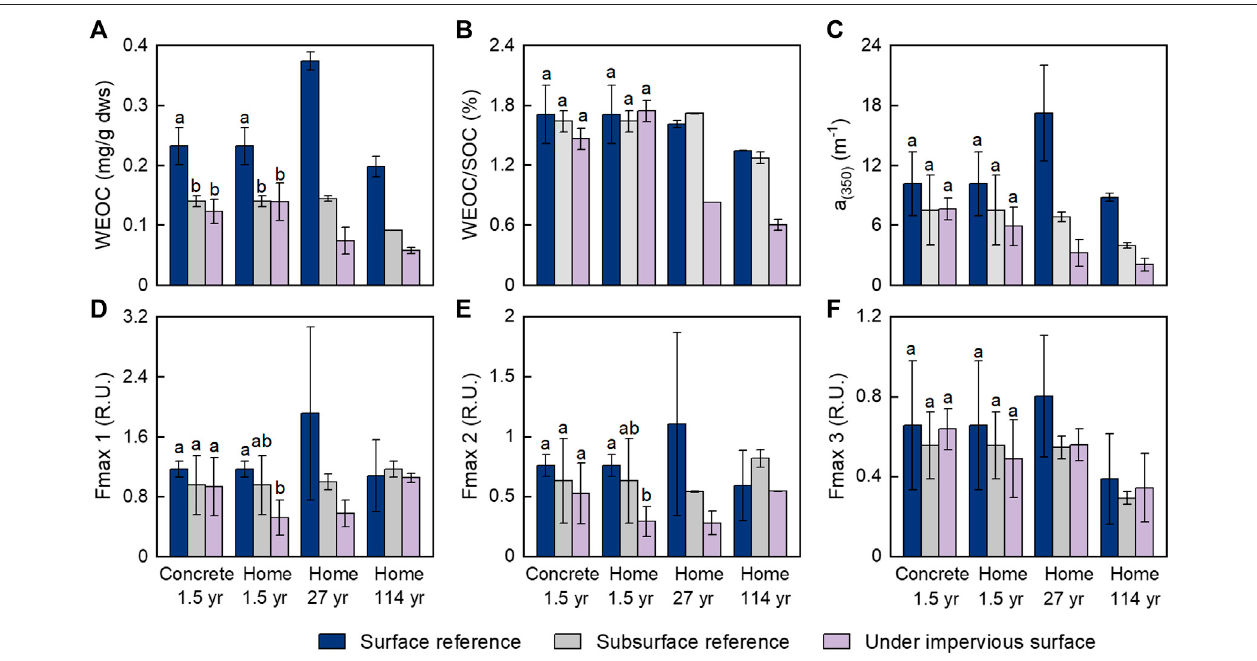
FIGURE 1| The variation in dissolved organic carbon in soils withand without coverageby impervious surfaces. (A) Total dissolved organic carbon concentration; (B) relativecontentofthedissolvedorganiccarbontothesoilorganiccarbon; (C) abundanceofthechromophoricdissolvedorganicmatter; (D – F) intensitiesofthethree components of the fl uorescent dissolved organic matter. Surface and subsurface references are surface (0 – 10 cm) soils and subsurface (10 – 20 cm) soils from nearby open areas without coverage by impervious surfaces. Treatment groups are soils with impervious surface coverage, which include 1.5 years of coverage by concrete slabs and simulated home structures and 27 and 114 years of coverage by residential home structures built on crawl spaces. For the concrete-1.5 years and home-1.5 years groups, error bars represent the SD ( n (cid:2) 4), lowercase letters indicate signi fi cantly different groups ( p < 0.05). For the other two groups, error bars represent the average deviation ( n (cid:2)